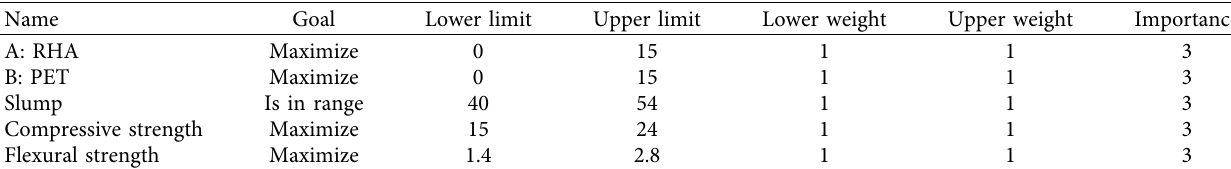
Figure 13: Response surface plot for fexural strength. Table 6: Optimization criteria of responses and